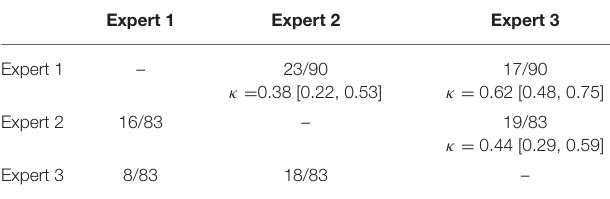
TABLE 2 | Inter-expert heterogeneity during phase 1.